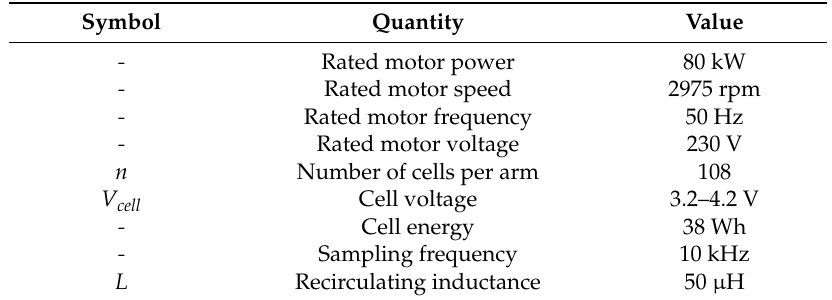
Table 2. Main Data of the Simulated